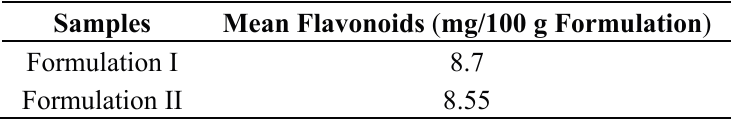
Table 2. Total flavonoids content in apitherapy